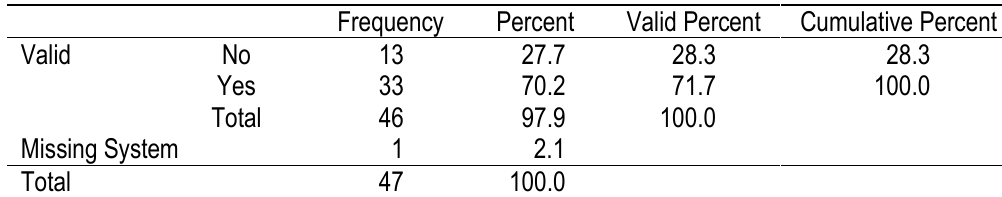
Table 1. “I think it is more difficult to learn science via distance education than the case of face-to-face”